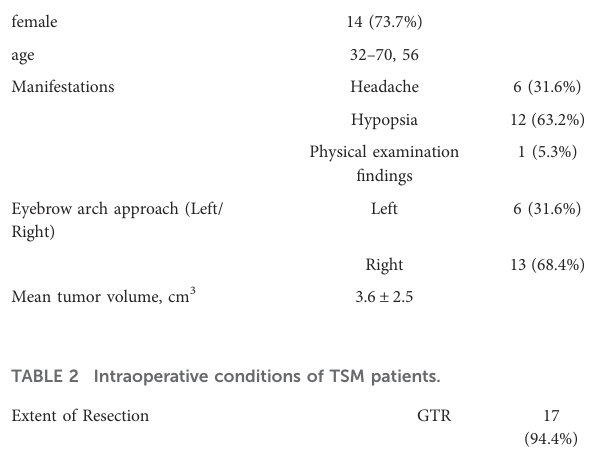
TABLE 2 Intraoperative conditions of TSM